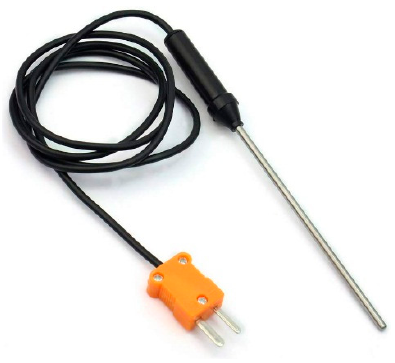
Figure 6. K-type thermocouple probe.